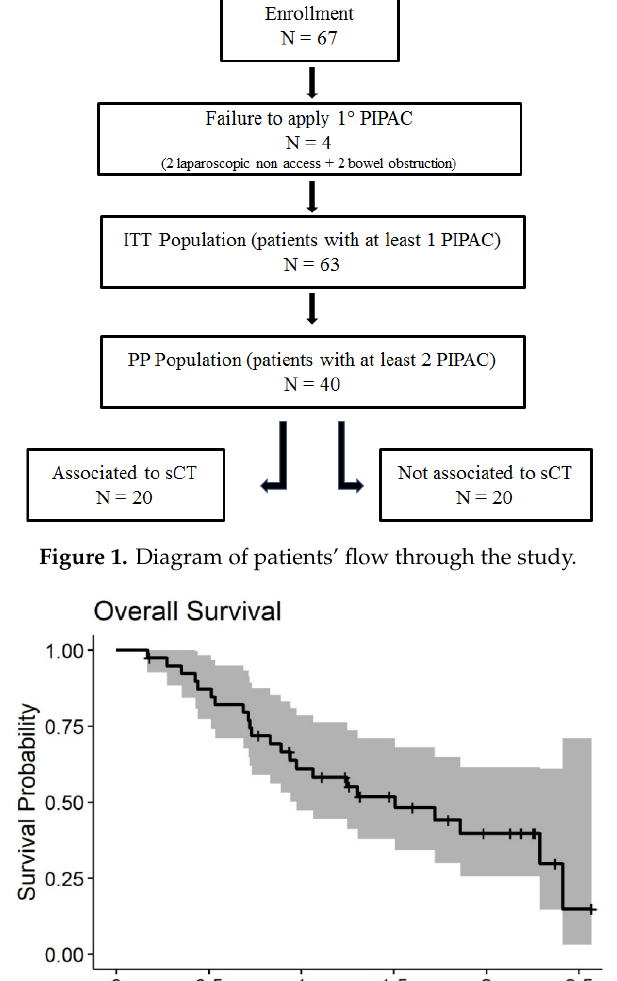
Figure 2. Overall survival of 20 patients with peritoneal carcinomatosis (PC) treated with at least two PIPAC procedures.